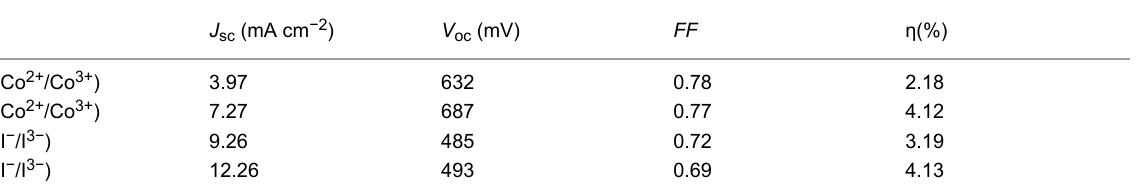
Table 2: Photovoltaic performances of DSSCs based on dyes 1 and 2 .